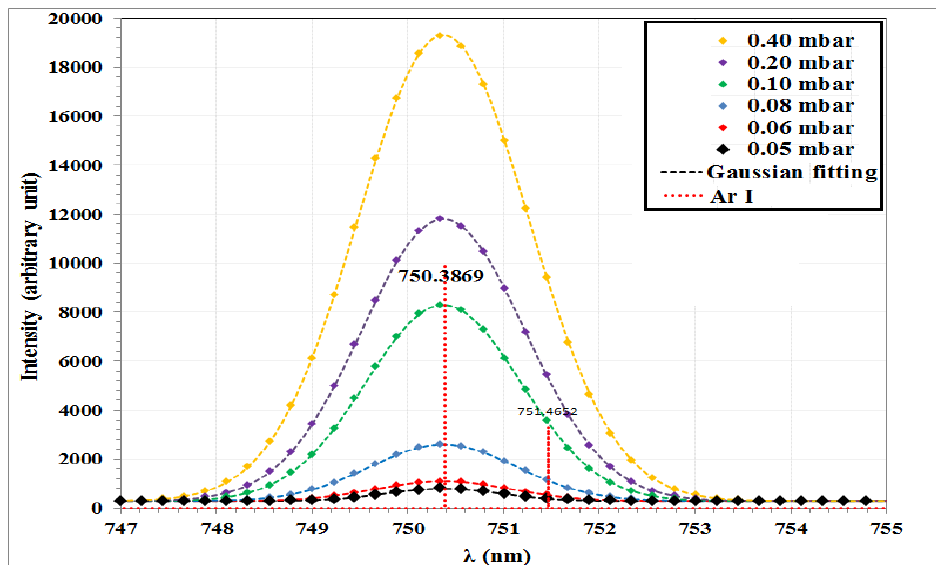
Fig. 3: Ar II 427.75 nm peaks broadening and there Gaussian fitting at different pressure.